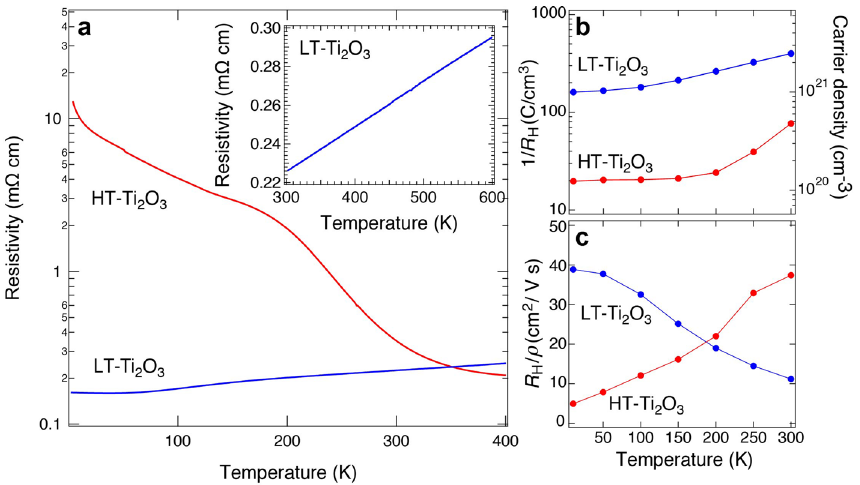
Figure 5. Electric properties of the Ti 2 O 3 films. ( a ) Temperature dependence of resistivity for the HT- and LT-Ti 2 O 3 films. The inset shows temperature dependence of resistivity for the LT-Ti 2 O 3 film above RT. Temperature dependence of the ( b ) inverse Hall coefficient 1/ R H and ( c ) Hall mobility R H / ρ of the HT- and LT-Ti 2 O 3